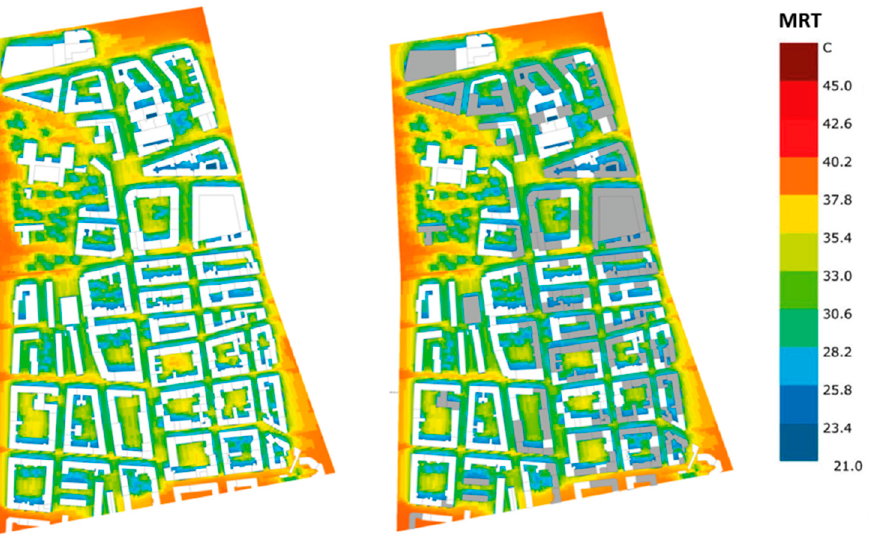
Figure 7. Twenty-four-hour mean radiant temperature (MRT) at street level for large-scale general densification impacts for base case ( left ) and densification scenario ( right ).